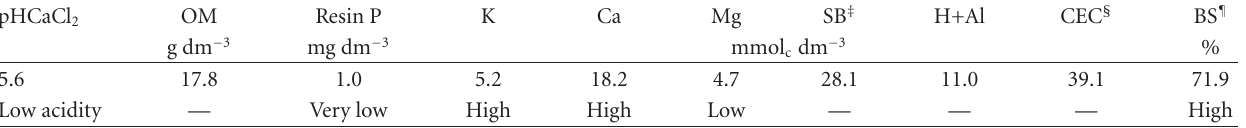
Table 1: Selected chemical characteristics of soil samples used in this study and interpretation of values † . pHCaCl 2